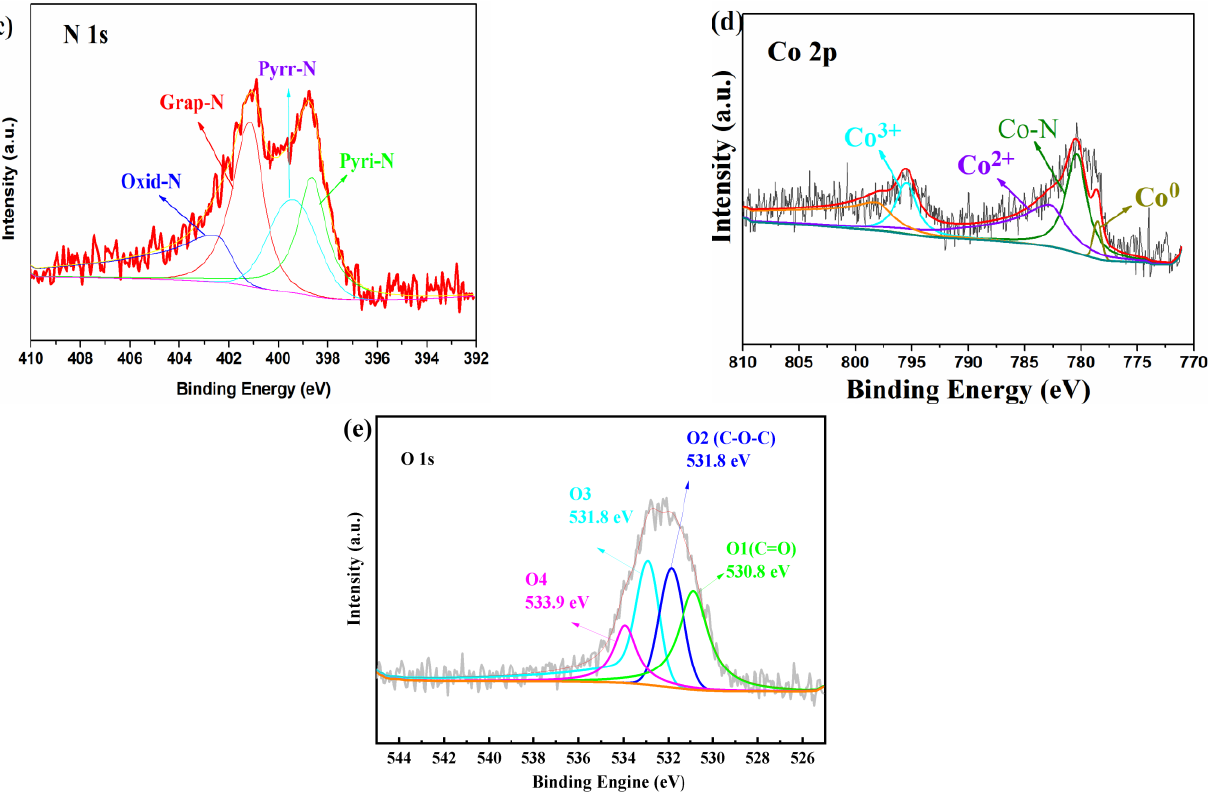
Figure 4. High-resolution XPS spectra of ( a ) XPS survey of the fresh and used Co-N-C, ( b ) C 1s, ( c ) N 1s, ( d ) Co 2p, and ( e ) O 1s.